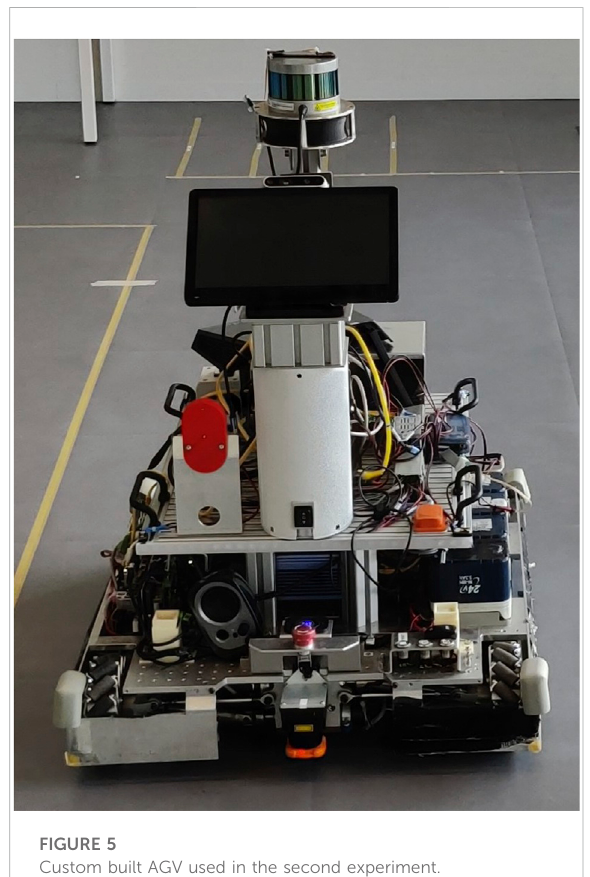
FIGURE 5 Custom built AGV used in the second